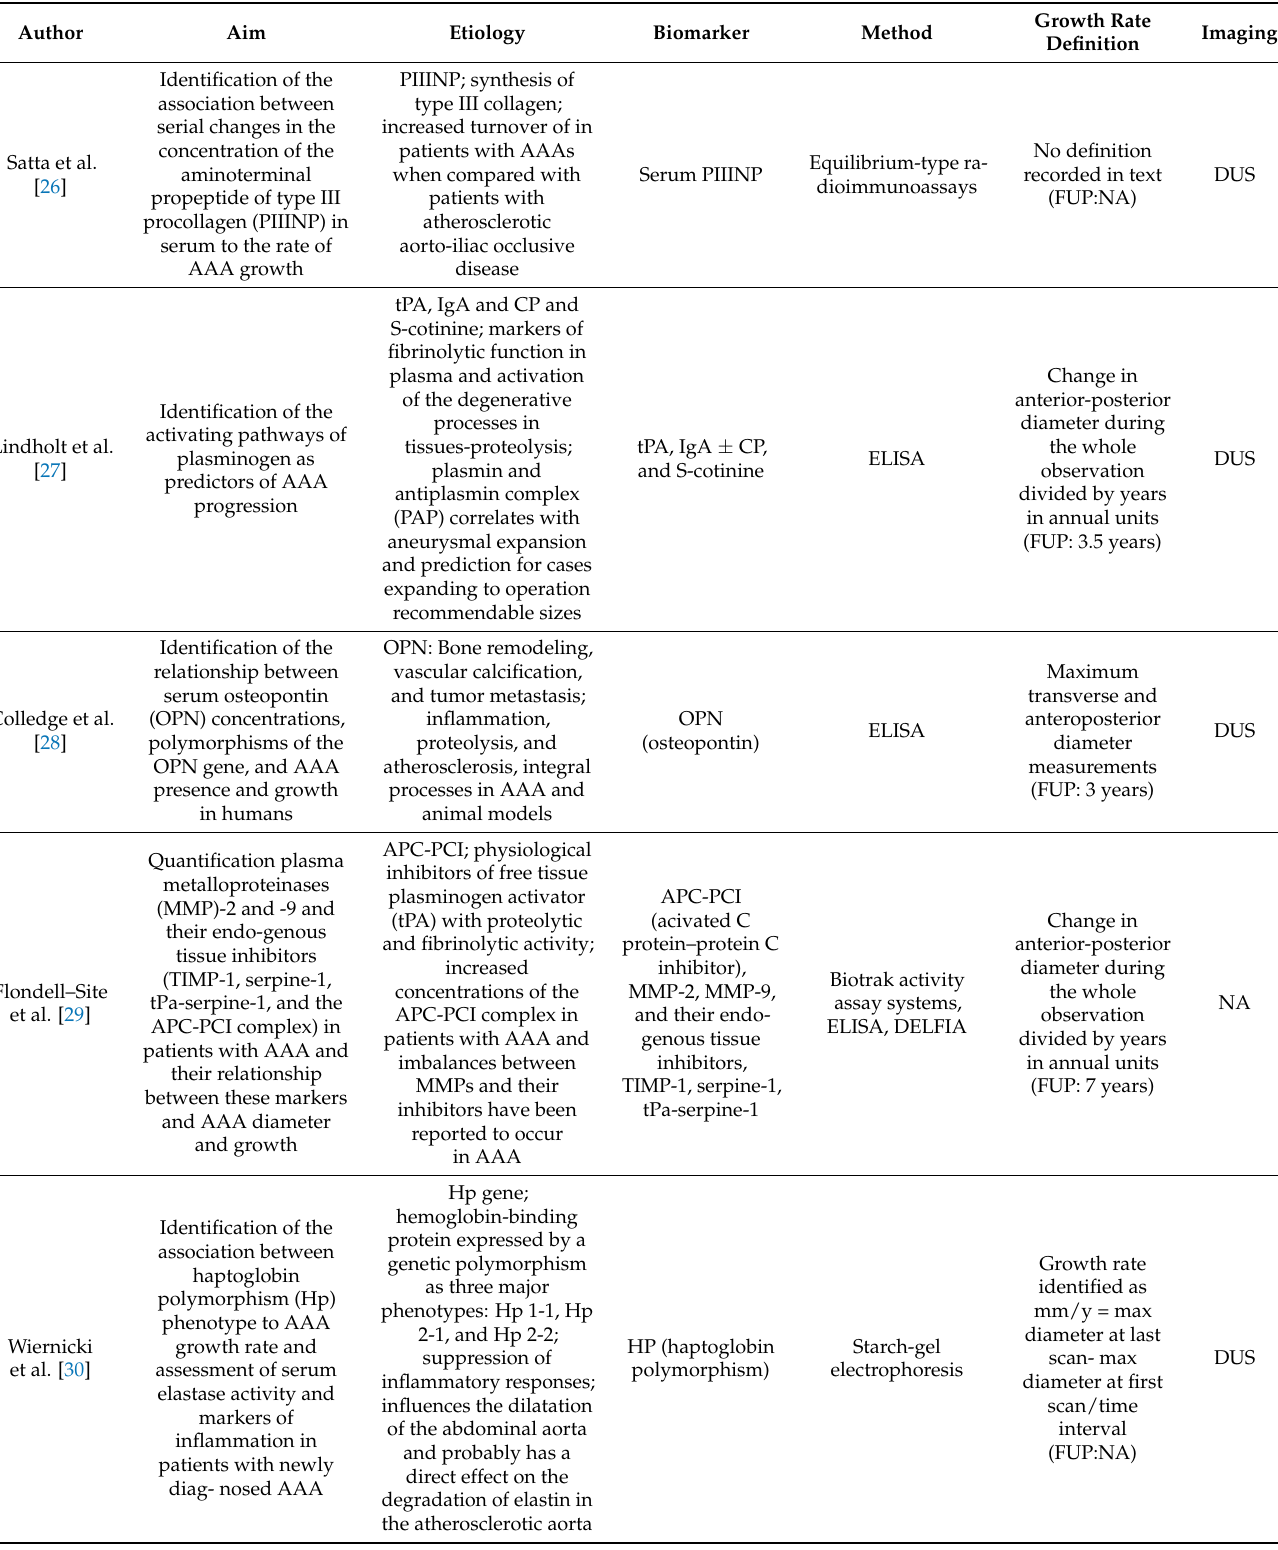
Table 4. Specific characteristics of studies on circulating experimental